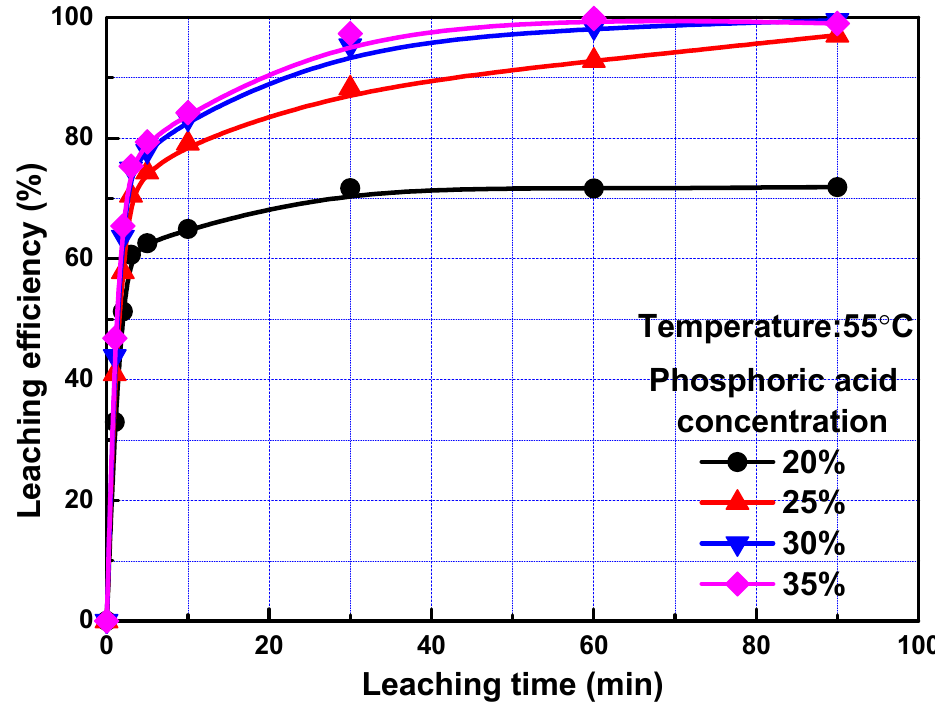
Figure 3. Leaching efficiency of REEs as a function of time at different phosphoric acid concentra- tion.